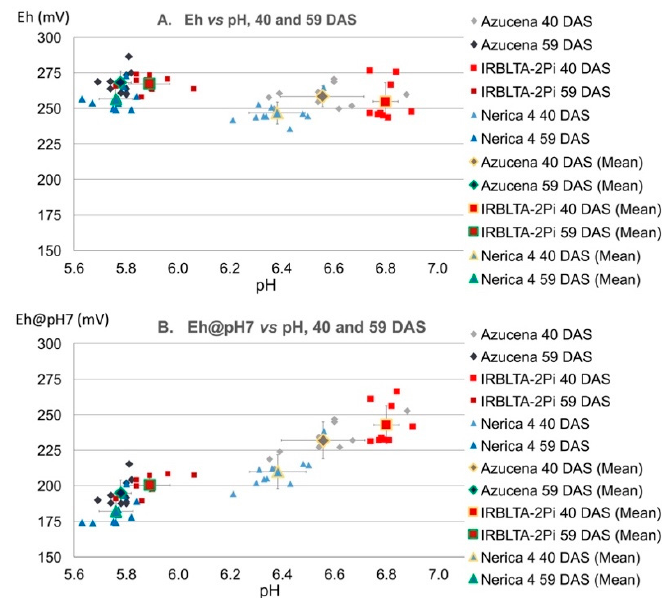
Figure 2. Varietal variability of leaf Eh, pH and Eh@pH7. pH-Eh ( A ) and pH-Eh@pH7 ( B ) diagrams for three varieties and two plant ages. Mean values for each group are indicated with standard deviation. Rice was grown in aerobic conditions, fertilized with Hoagland solution. Data are from season IV, sown 2 December 2016. Measurements were made on the middle part of the last fully expanded leaf of the main tiller.